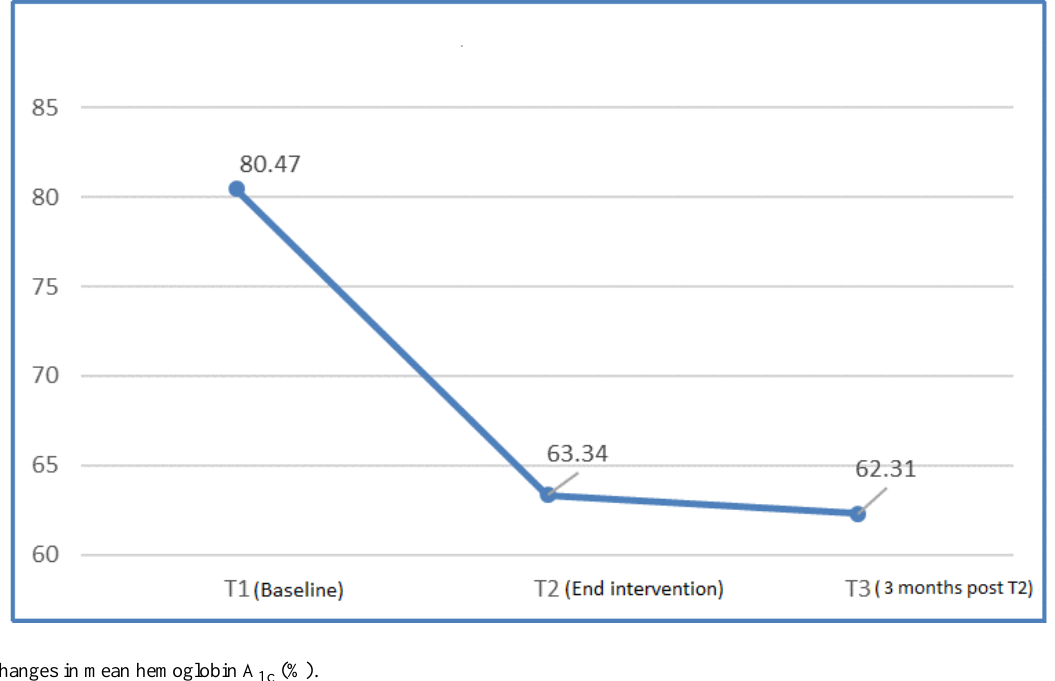
Figure 3. Changes in mean hemoglobin A 1c (mmol/L).